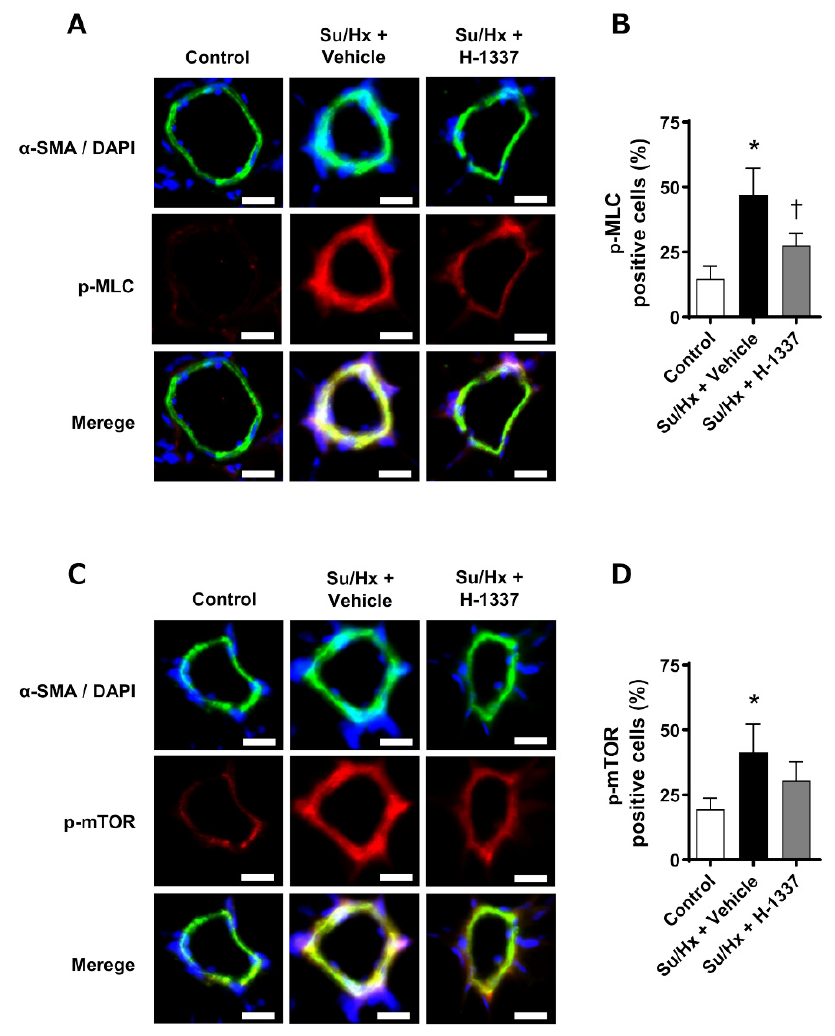
Figure 6. Phosphorylation of MLC and mTOR was suppressed by H-1337 in pulmonary arteries. ( A ) Immunofluorescence of α -smooth muscle actin ( α -SMA, green) and phospho-myosin light chain (MLC, red) in pulmonary arteries. Nuclei were counterstained with DAPI (blue). ( B ) Quantification of the immunofluorescence of phosphorylated MLC (p-MLC). ( C ) Representative images of immunofluorescence of α -SMA (green) and phospho-mammalian target of rapamycin (mTOR, red) in pulmonary arteries. Nuclei were counterstained with DAPI (blue). ( D ) Quantification of the immunofluorescence of phospho-mTOR. Su/Hx + H-1337: H-1337-treated Su/Hx rats ( n = 3); Su/Hx + vehicle: vehicle-treated Su/Hx rats ( n = 3); and control: untreated rats ( n = 3). All scale bars indicate 10 µm. *: analyzed by ANOVA, p < 0.05 versus the control; †: p < 0.05 versus the Su/Hx + vehicle group.